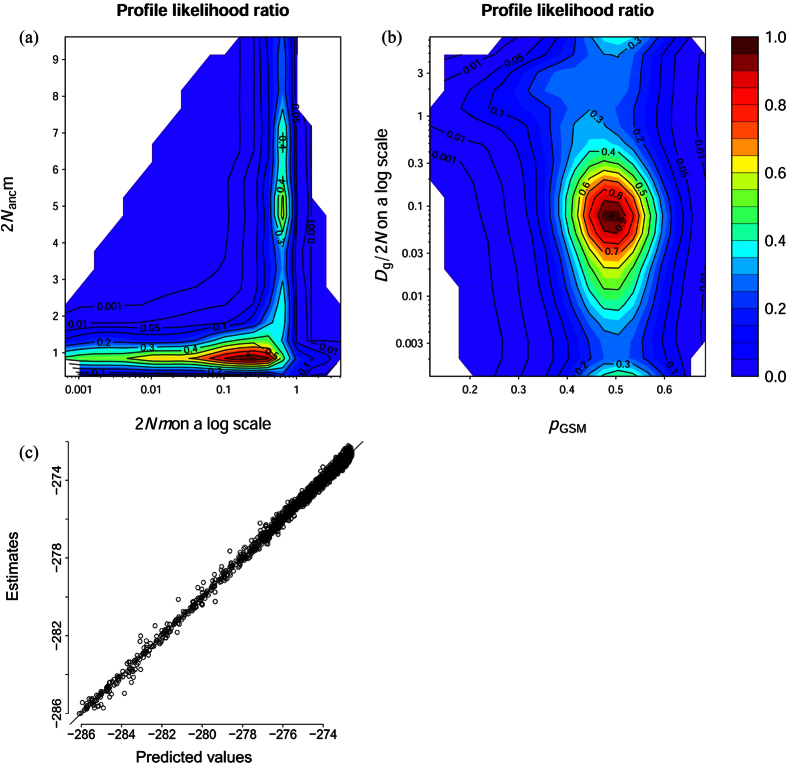
A two-dimensional profile likelihood ratio for (a) θ vs. θanc, (b) Dg/2N vs. pGSM and (c) the diagnostic plot of kriging.